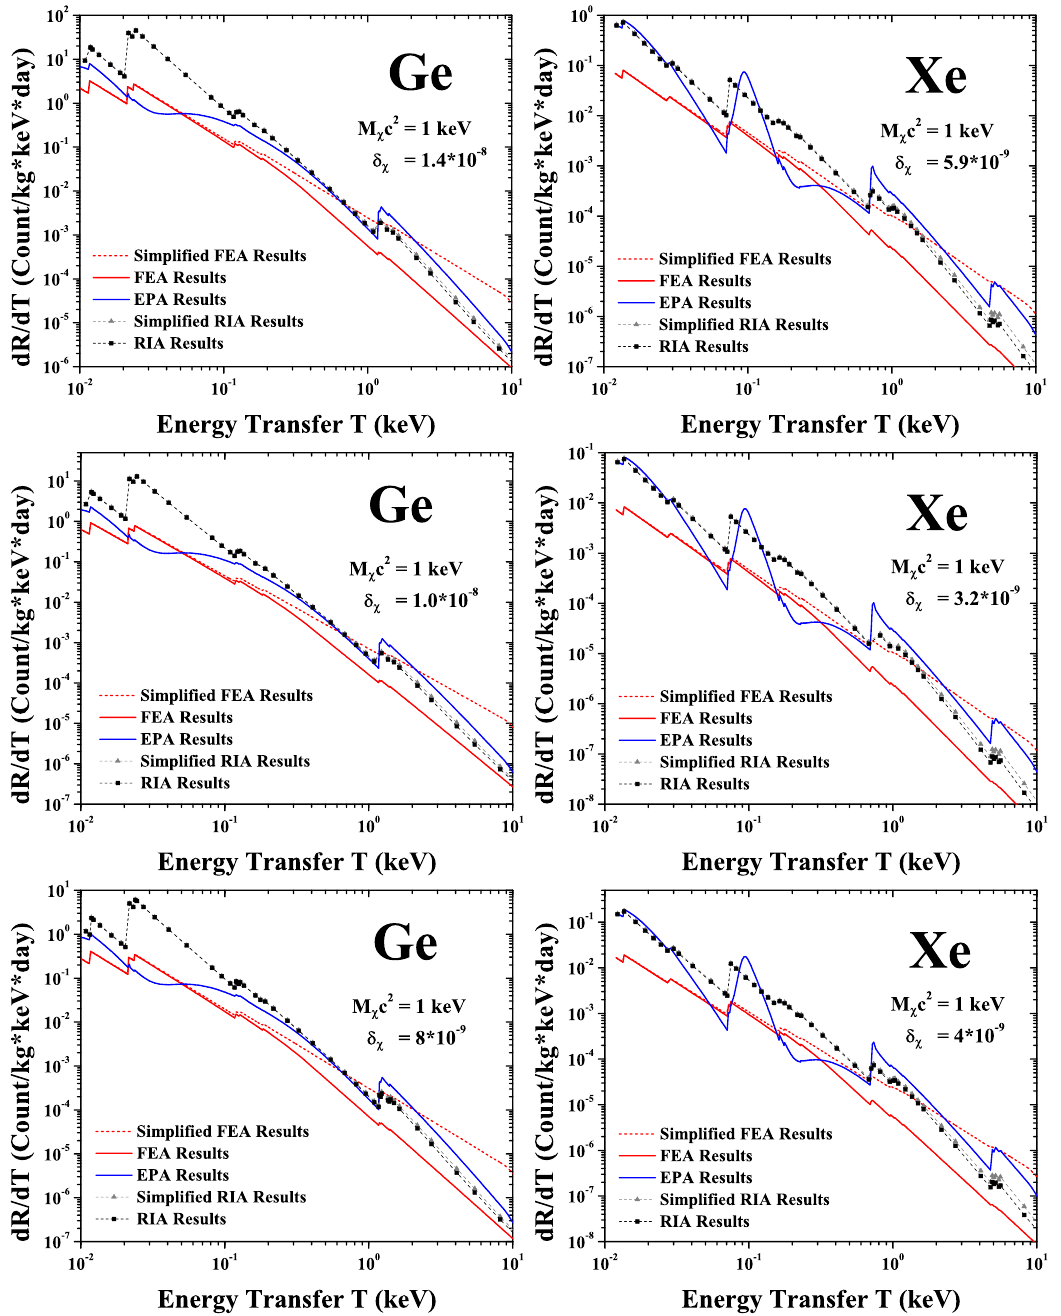
Figure 12 . The differential reaction event rates for the atomic ionization process induced by millicharged particles in HPGe and LXe detectors. The mass of millicharged dark matter particle is set as m is chosen such that the reaction event rates in HPGe 2 = 1 keV, and its millicharge δ χ c χ and LXe detectors match the experimental background levels for next-generation experiments, respectively. In this figure, the horizontal axis represents the energy transfer T , and the vertical axis represents the differential event rate dR/dT in unit of cpkkd. The same as in figure 6 and figure 9, the red solid lines correspond to the FEA results; red dashed lines represent the simplified FEA results; blue lines stand for the EPA results; black squares display the RIA results; gray triangles show the simplified RIA